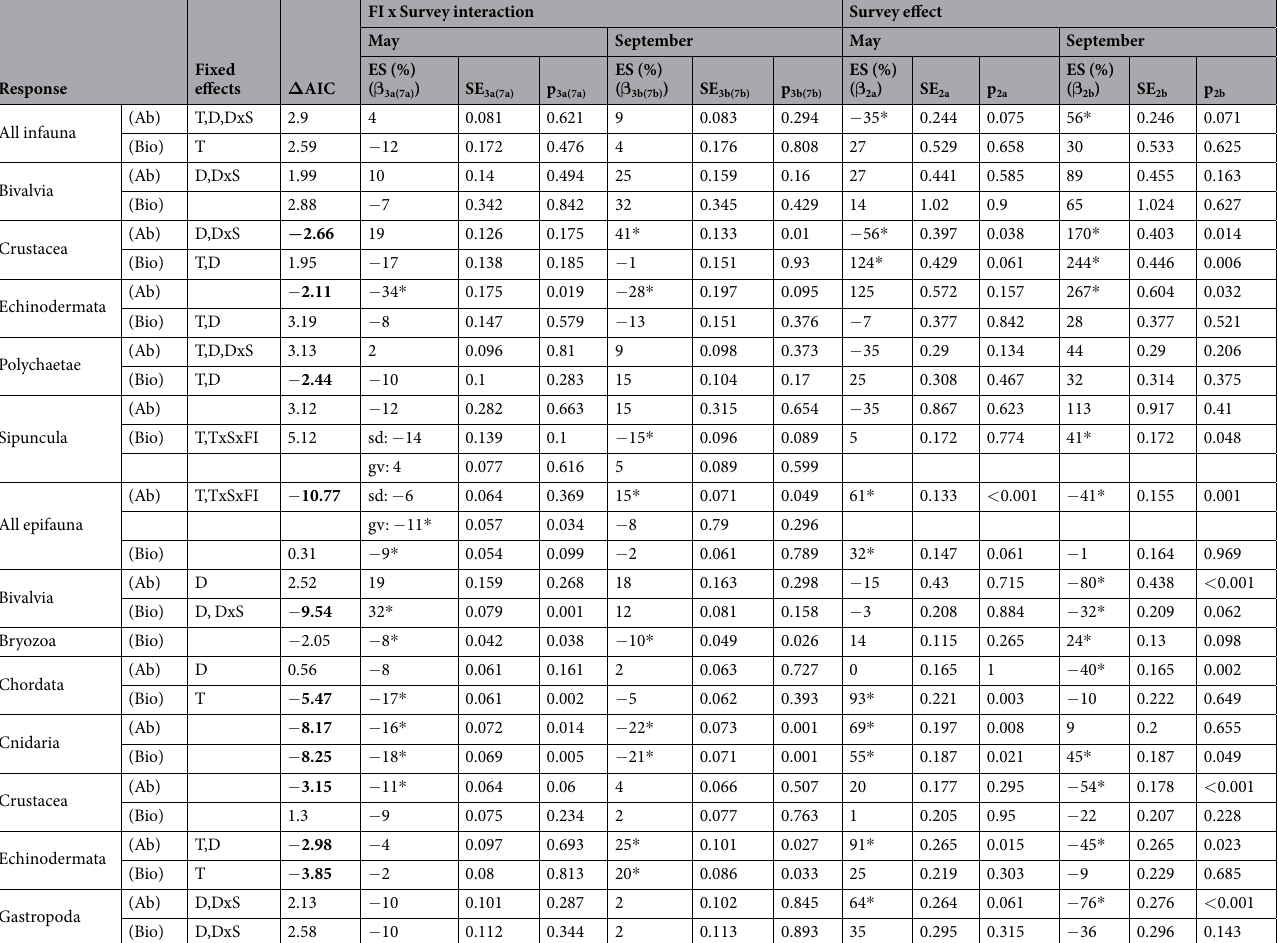
Table 2. Results of the GLMMs for the BACI experiment on infaunal and epifaunal abundance (Ab) and biomass (Bio) at the population and class or phylum level, for a continuous gradient of fishing intensity (FI). S = Survey time, T = Texture, D = Depth. All models include the fixed effects S, FI and SxFI, plus the effects indicated in the table. Δ AIC is the difference in AIC between models with and without the ‘time x treatment’ interaction (i.e. SxFI) -a negative value (bold) means that the model with interaction is better (i.e. significant effect of the fishing gradient). β 3a(7a) and β 3b(7b) are the estimates of the ‘S x FI’ interaction as in eq1 for ‘before’ to ‘after’ and ‘before’ to ‘4 months after fishing’ respectively, with corresponding standard errors (SE) and p-values (p). β 2a and β 2b are the estimates (with s.e. and p-values) of the survey effect alone (i.e. natural variation in time). Here we give ES, i.e. effect size equal to [exp( β )-1] * 100, instead of β , for interpretability. ES is the percentage change (in abundance or biomass) per dredge pass compared to March. ‘gv’ and ‘sd’ refer to gravel and sand where the interaction with texture was in the best model. The symbol * identifies the significant ES with α = 0.1. P. maximus and O. fragilis were excluded from the epifaunal